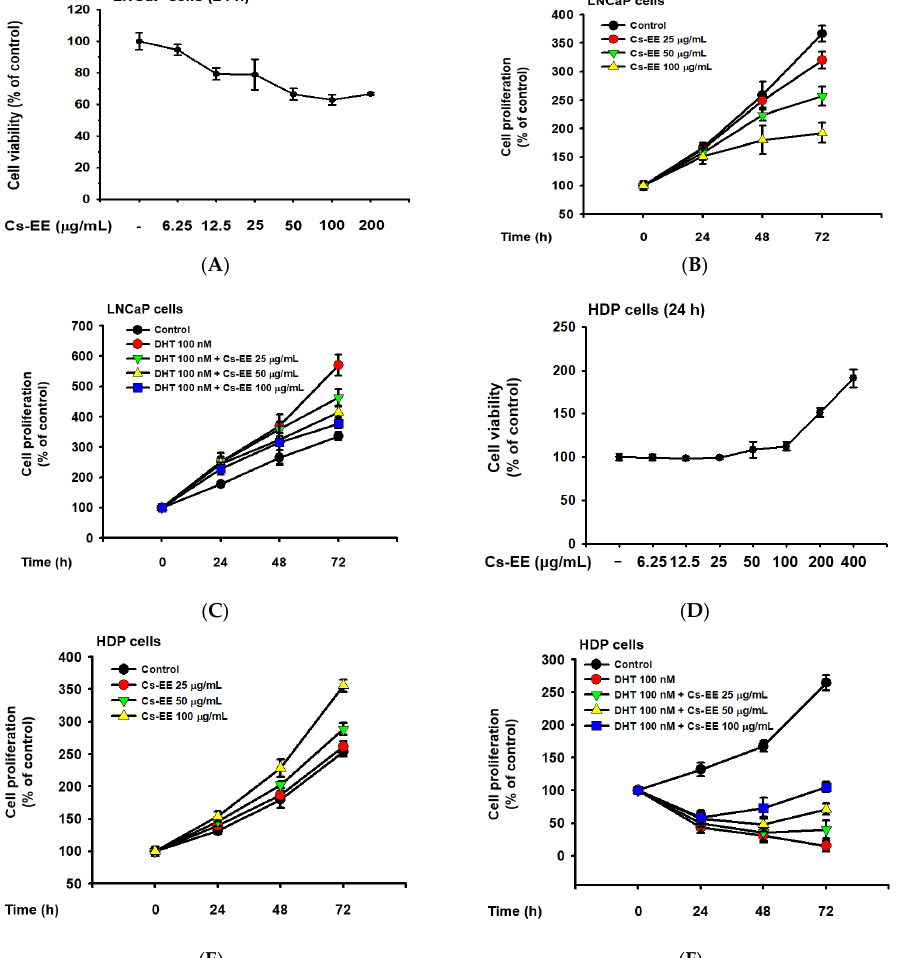
Figure 5. Cs-EE inhibited the survival and proliferation of an androgen-dependent prostate cancer cell line (LNCaP) and upregulated the survival and proliferation of human dermal papilla (HDP) cells. ( A ) Cell viability assay using MTT solution with different Cs-EE concentrations. ( B , C ) LNCaP proliferation was detected in both the DHT-treated and untreated conditions in 0, 25, 50, and 100 μg/mL of Cs-EE. ( D ) The cytotoxicity of Cs-EE on HDP cells was measured using the MTT assay. ( E , F ) HDP proliferation in different concentrations of Cs-EE was evaluated in the DHT-treated and -untreated conditions.